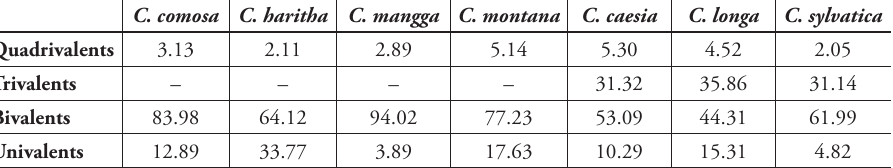
Table 3. Percentage of chromosome associations during male meiosis in Curcuma